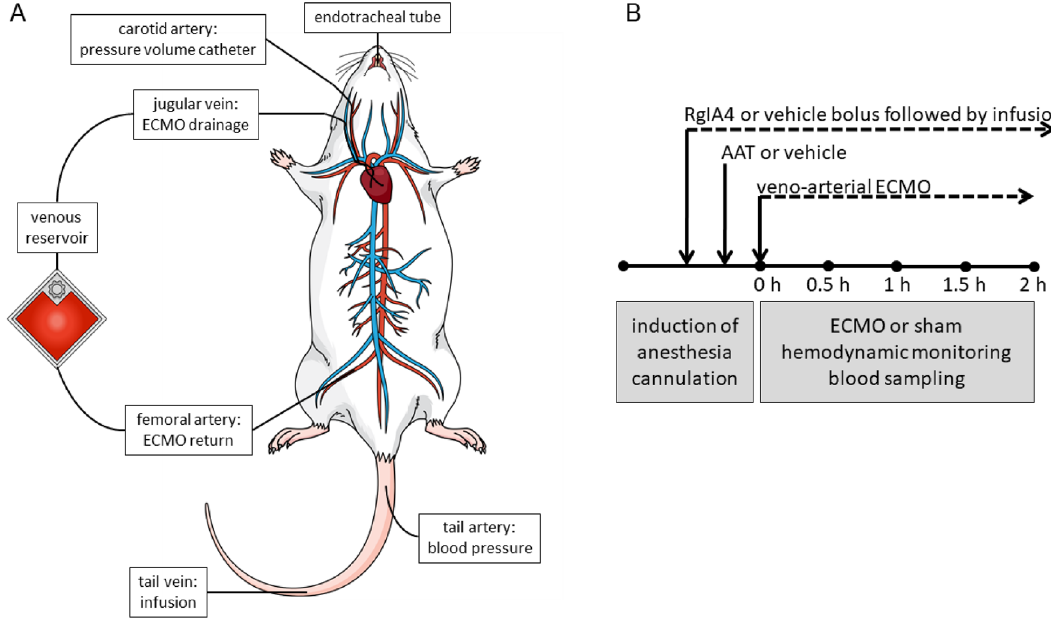
Figure 1. Design of the study. ( A ) Cannulation strategy used for experimental veno-arterial extracorporeal membrane oxygenation (ECMO) in the rat. The animals were endotracheally intubated and ventilated. The right atrium was cannulated via the jugular vein for venous blood drainage. Venous blood passed through the ECMO device and the oxygenized and carbon dioxide cleared blood was returned via the femoral artery. A pressure volume catheter was placed into the left ventricle through the right carotid artery. The peripheral blood pressure was measured in the tail artery. The lateral tail vein was punctured for infusion of medicaments and the test substances under investigation. ( B ) Graphical visualization of the time course of the experiments. Rats were anesthetized and treated with the conopeptide RgIA4 or vehicle, which were given as a bolus followed by continuous infusion. α1-antitrypsin (AAT) or vehicle were applied by syringe pump over 5 min. Thereafter, veno-arterial ECMO was started and hemodynamic monitoring as well as blood sampling was done for 2 h. Thereafter, animals were sacrificed. The same procedure was applied to sham-treated animals, but the ECMO was